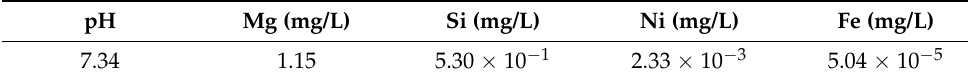
Table 1. Initial solution composition for the evaporation step from [2].